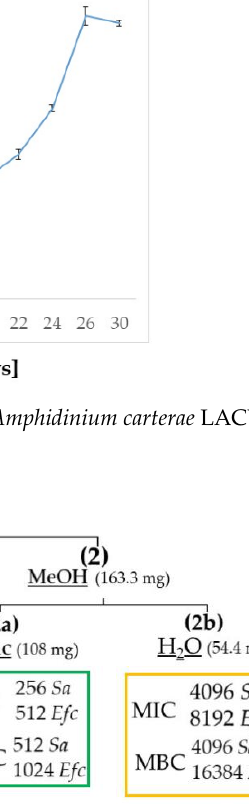
Figure 3. Representative scheme of Stage-1: three extracts obtained from Amphidinium carterae LACW11 biomass (freeze dried, mg) were screened against Gram-positive bacteria. Activities are expressed in µg/mL. Sa , Staphylococcus aureus ATCC 25,293; Efc , Enterococcus faecalis ATCC 29,212. The bioactivities of each extract are highlighted with different colours.